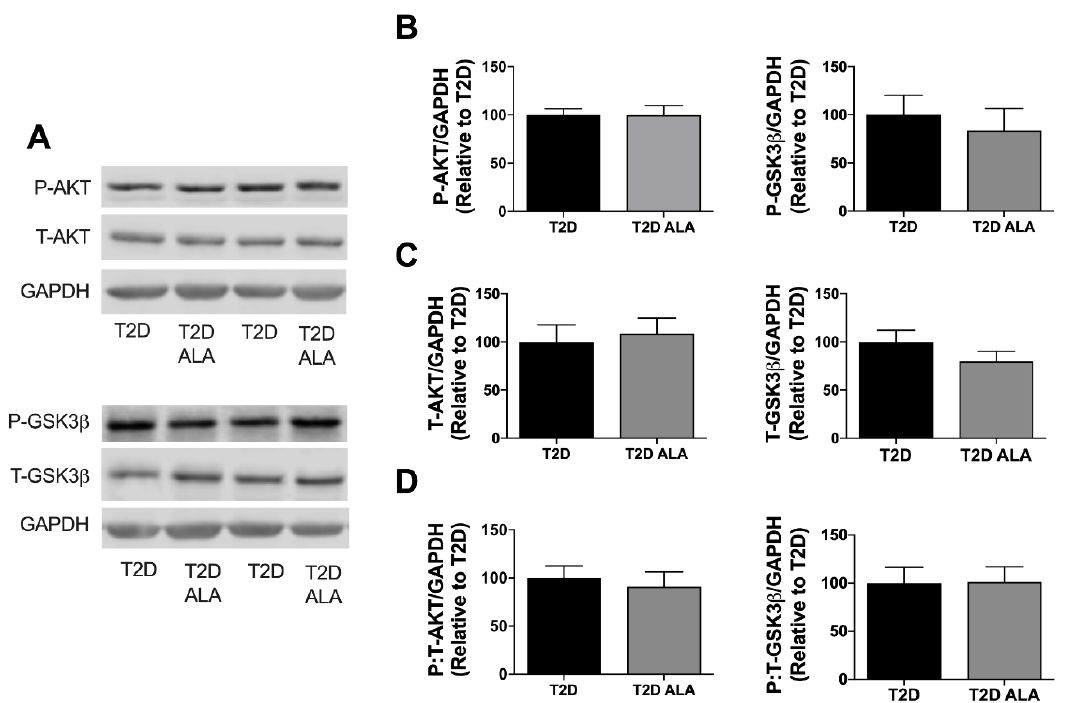
Figure 5. Cytosolic AKT and GSK3 β expression and phosphorylation in myocardial lysates from T2D mice ± dietary ALA supplementation. ( A ) Representative blots; ( B ) phosphorylated AKT and GSK3 β expression; ( C ) total AKT and GSK3 β expression; ( D ) and ratio of phosphorylated:total AKT and GSK3 β expression. Protein expression was normalized to GAPDH and expressed relative to the untreated T2D group. Results presented as means ± SEM ( n = 6 / group for all proteins). No significant effects of ALA supplementation were detected.